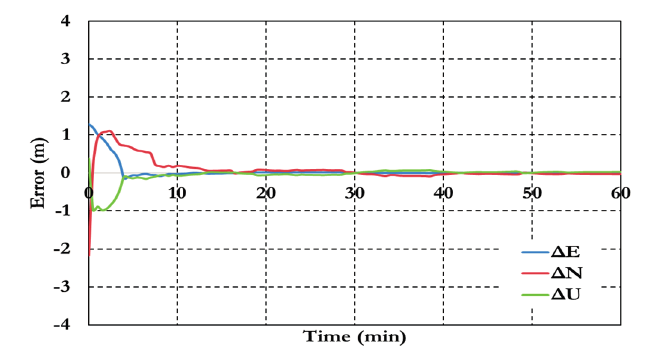
Figure 18. Positioning results of the BSSD PPP loose combination model.